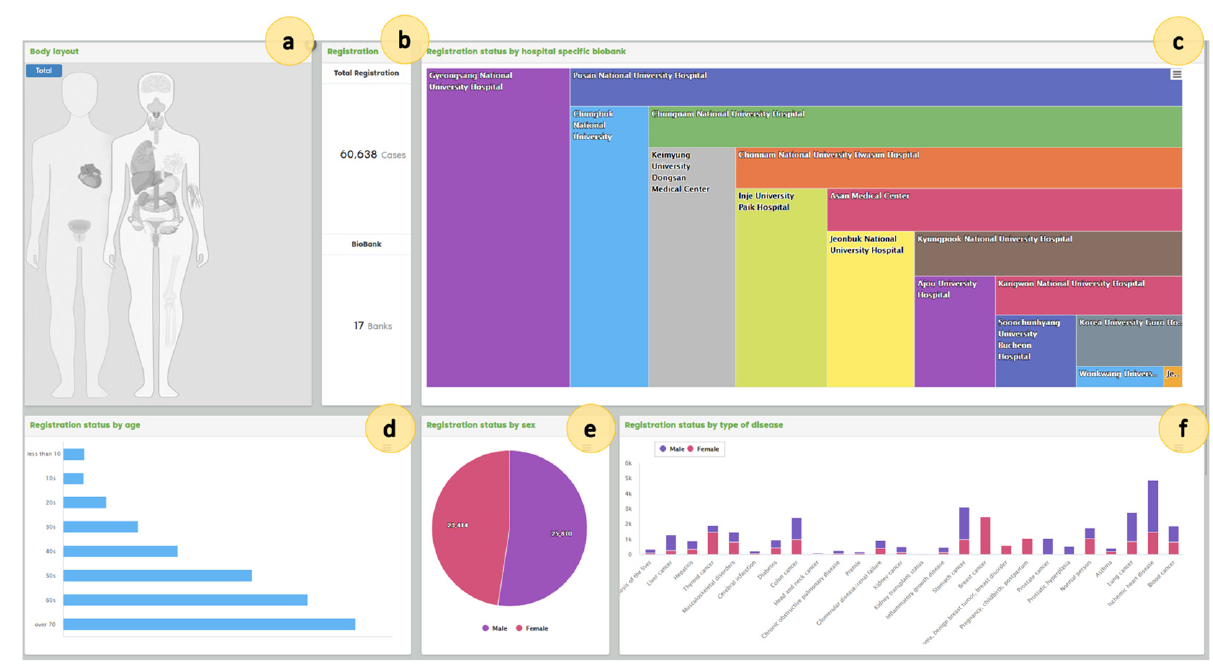
Figure 4. KBN Dashboard screenshot: ( a ) body layout, ( b ) registration status, ( c ) registration status with respect to each hospital-specific biobank, ( d ) registration status by age, ( e ) registration status by sex, and ( f ) registration status by type of disease.